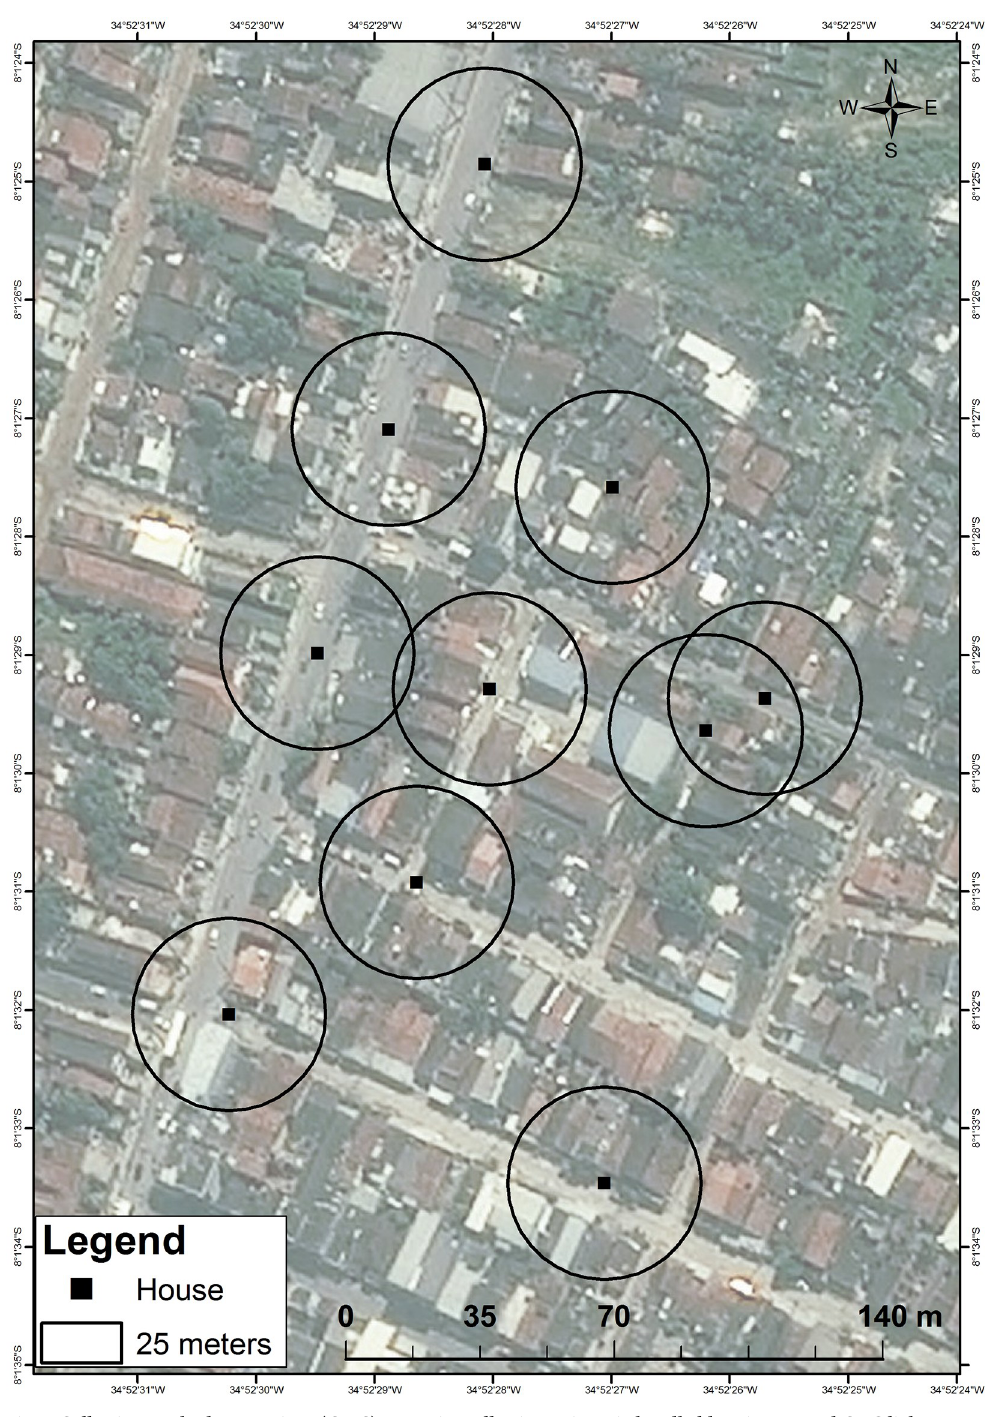
Fig 2. Collection method comparison (CMC) mosquito collection points via handheld aspirators and CDC light traps, Sı´tio Novo, Olinda, RMR, Brazil, July 22–August 21, 2015.